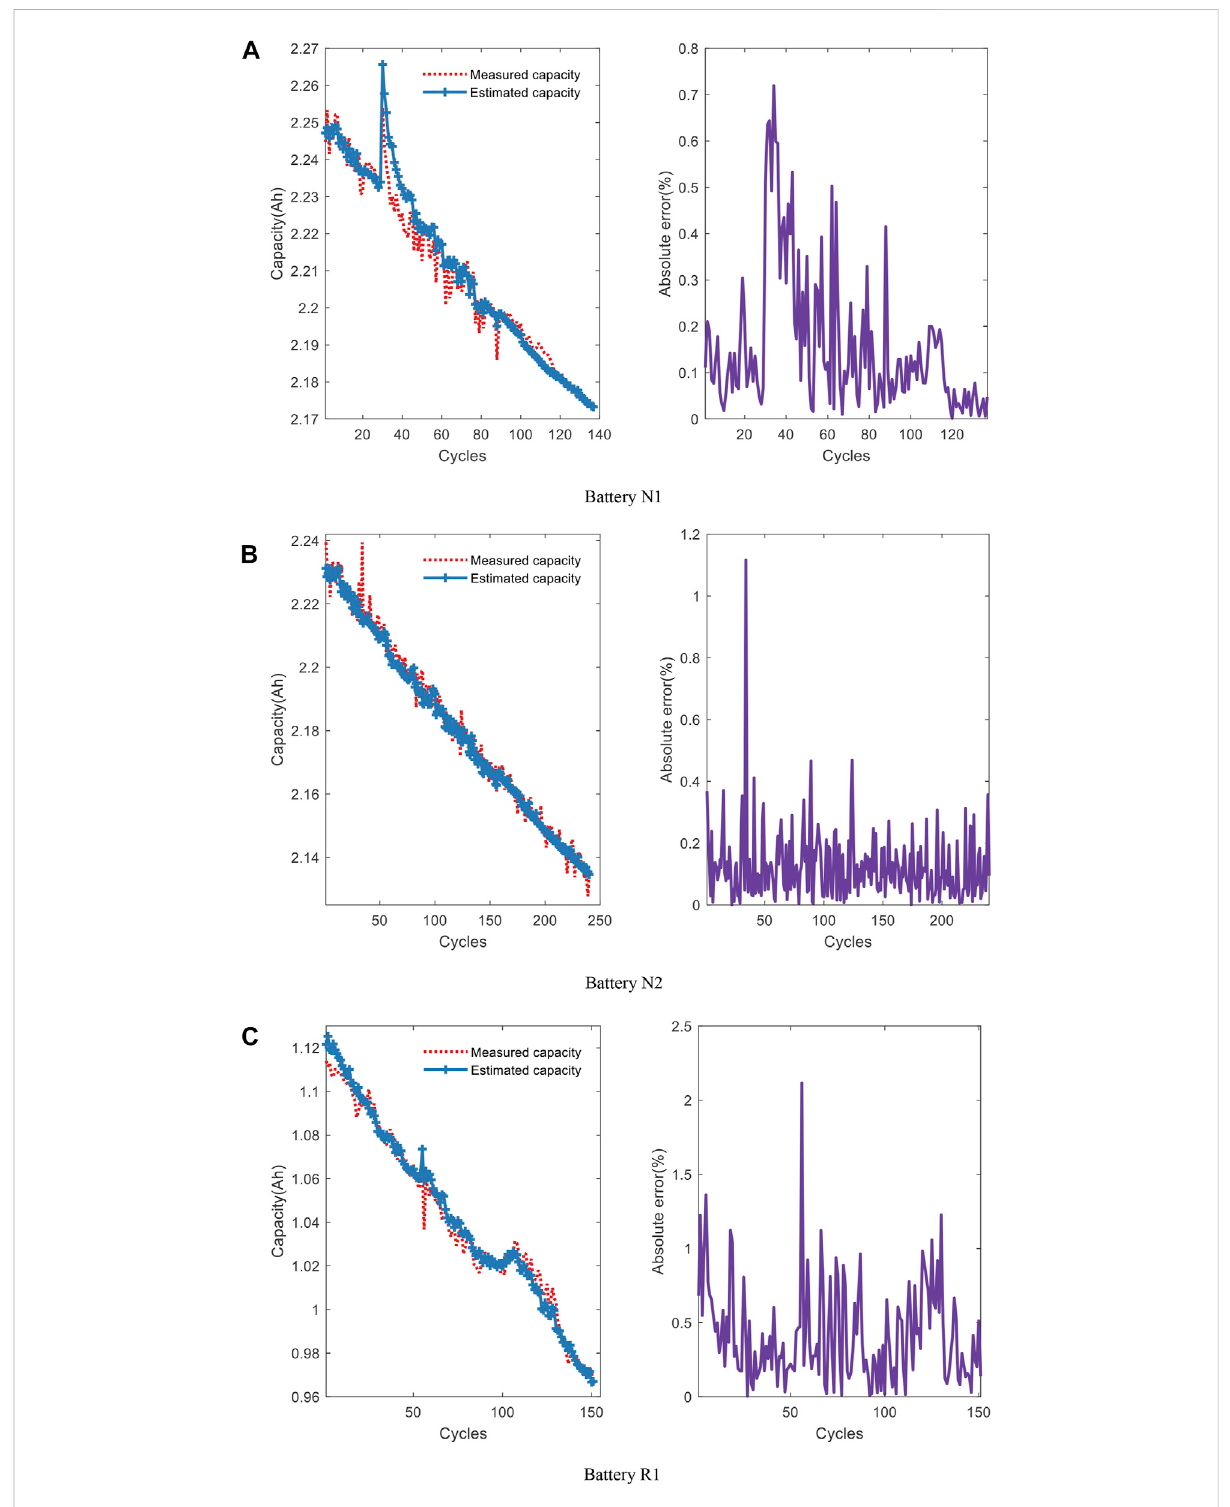
FIGURE 8 The results and absolute error of estimation experiment for batteries N1, N2, and